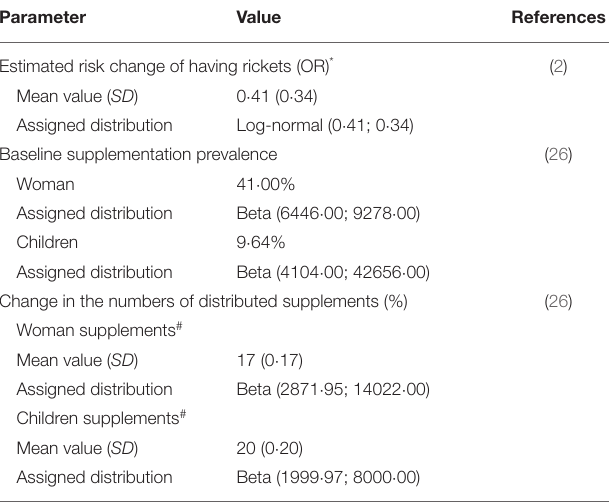
TABLE 2 | Estimated intervention effect on rickets and Healthy start supplement uptake.